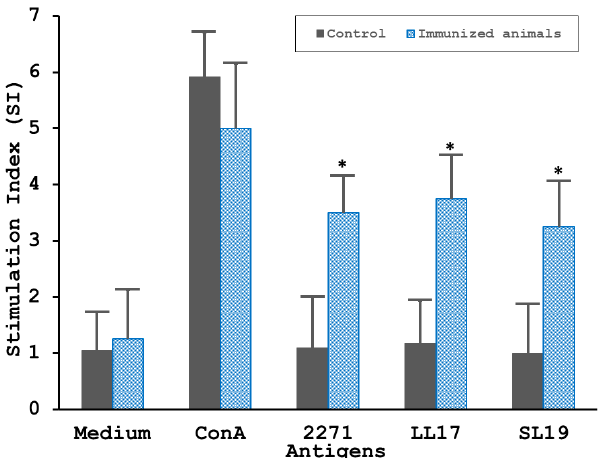
Figure 4. The proliferation of splenocytes in response to the rhKU_Sej_LRR_2271 protein . Splenocytes isolated from the spleens of control hamsters ( n = 5) and hamsters immunized with 2271 protein ( n = 5) 3 weeks after the 2nd immunization before a challenge were cultured in flat-bottomed 96-well microtiter plates. The cells were stimulated with 10 µg/mL of an individual antigen, including the rhKU_Sej_LRR_2271 protein, LL17, and SL19 peptides, as described in Section 2.7. Splenocytes stimulated with ConA or medium were considered positive and negative controls, respectively. The proliferative capacity was deliberated using the Click-iT EdU Proliferation Assay for Microplates (Invitrogen, Thermo Fisher Scientific) as per the manufacturer’s protocol. The data represents mean ± S.E.M., and the * represents the statistically significant differences ( p- value < 0.05) determined using the Mann-Whitney U test.